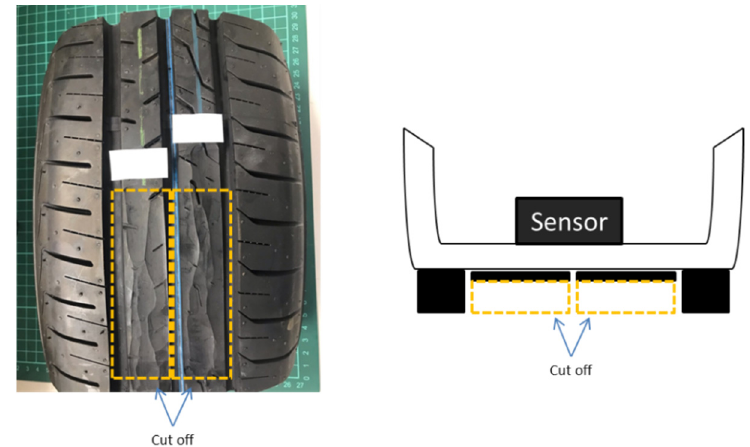
Figure 6. Schematic diagram of the tire block section.